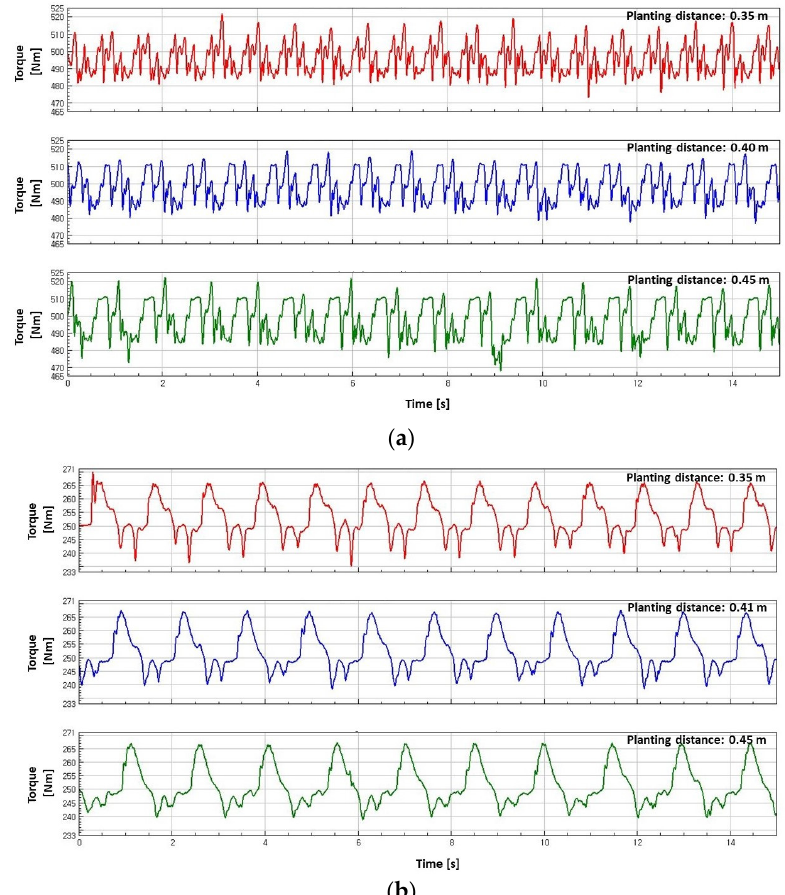
Figure 12. Measured torque of the transplanting device input shaft at an engine speed of 1250 rpm: ( a ) cam and ( b ) four-bar-link types.